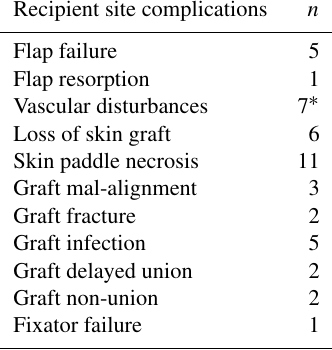
Table 5. Recipient site complications following VFF.